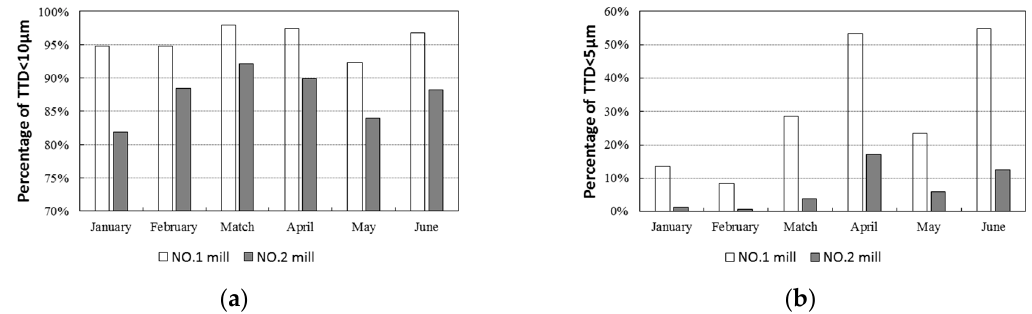
Figure 10. Statistics of transverse thickness difference (TTD) of strip produced by two rolling mills: ( a ) Less than 10 µ m; ( b ) less than 5 µ m.